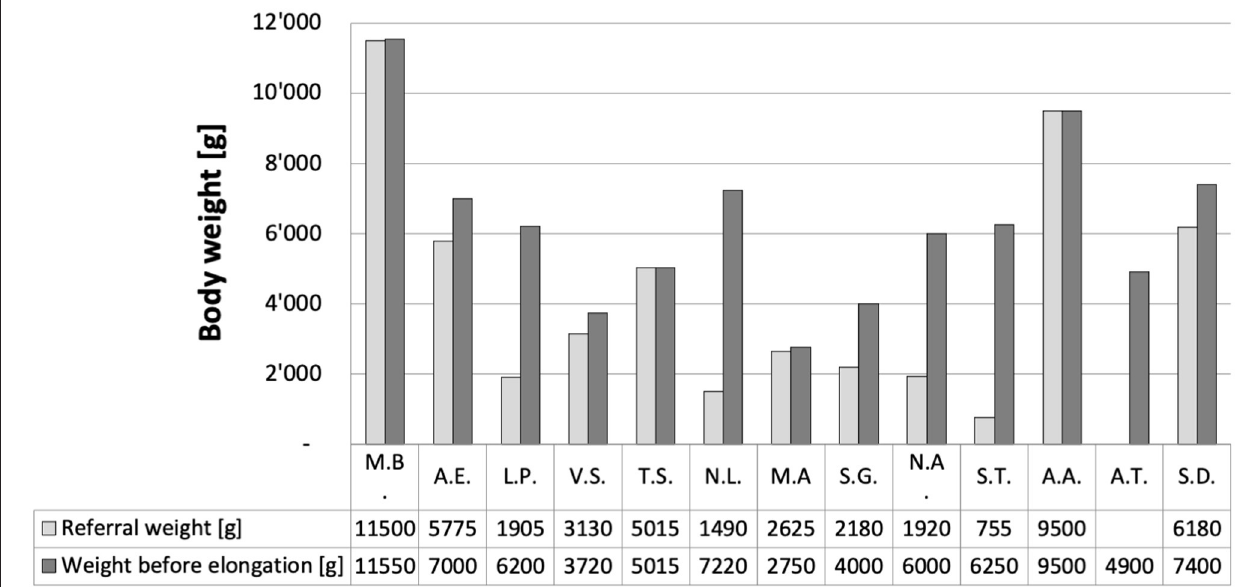
FIGURE 3 | Body weight of our 13 patients. Weight at referral ranged from 755 to 11’500g (median 2*877g). Weight immediately before the first elongation ranged from 2’705 to 9’500g (median 6’100g).